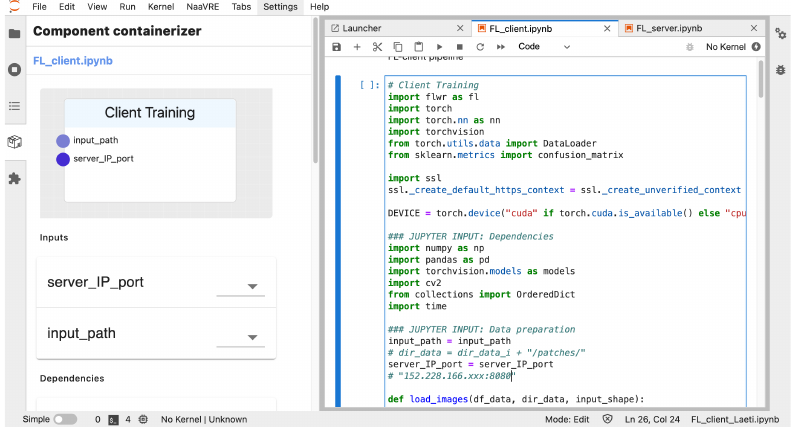
Figure 4. Demonstration of the Notebook Federator method with component containerizer in a Jupyter Notebook: building reusable FL pipeline blocks, e.g., Client Training